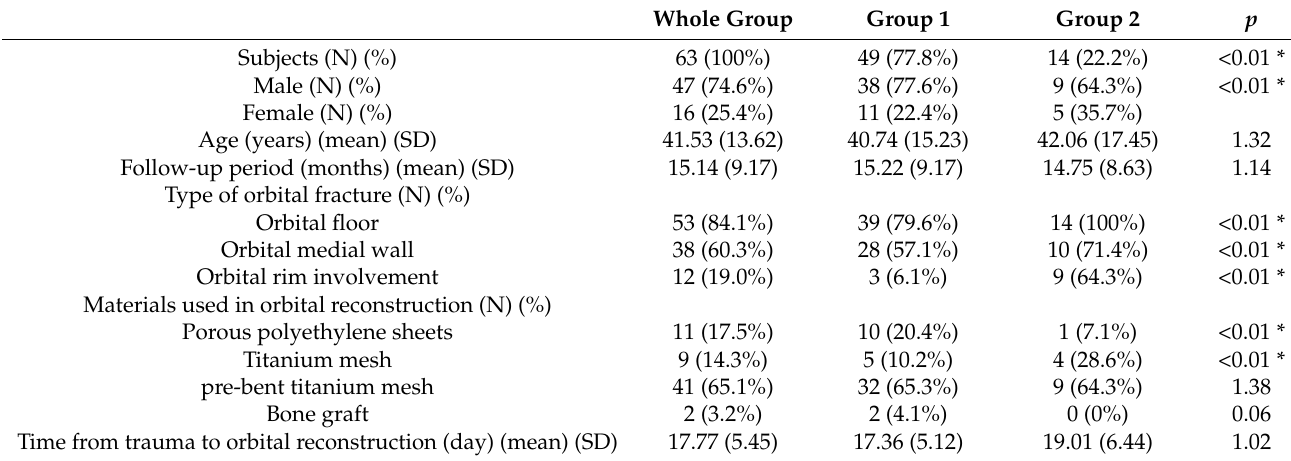
Table 1. Demographic characteristics of patients in the study. Whole Group Group 1 Group